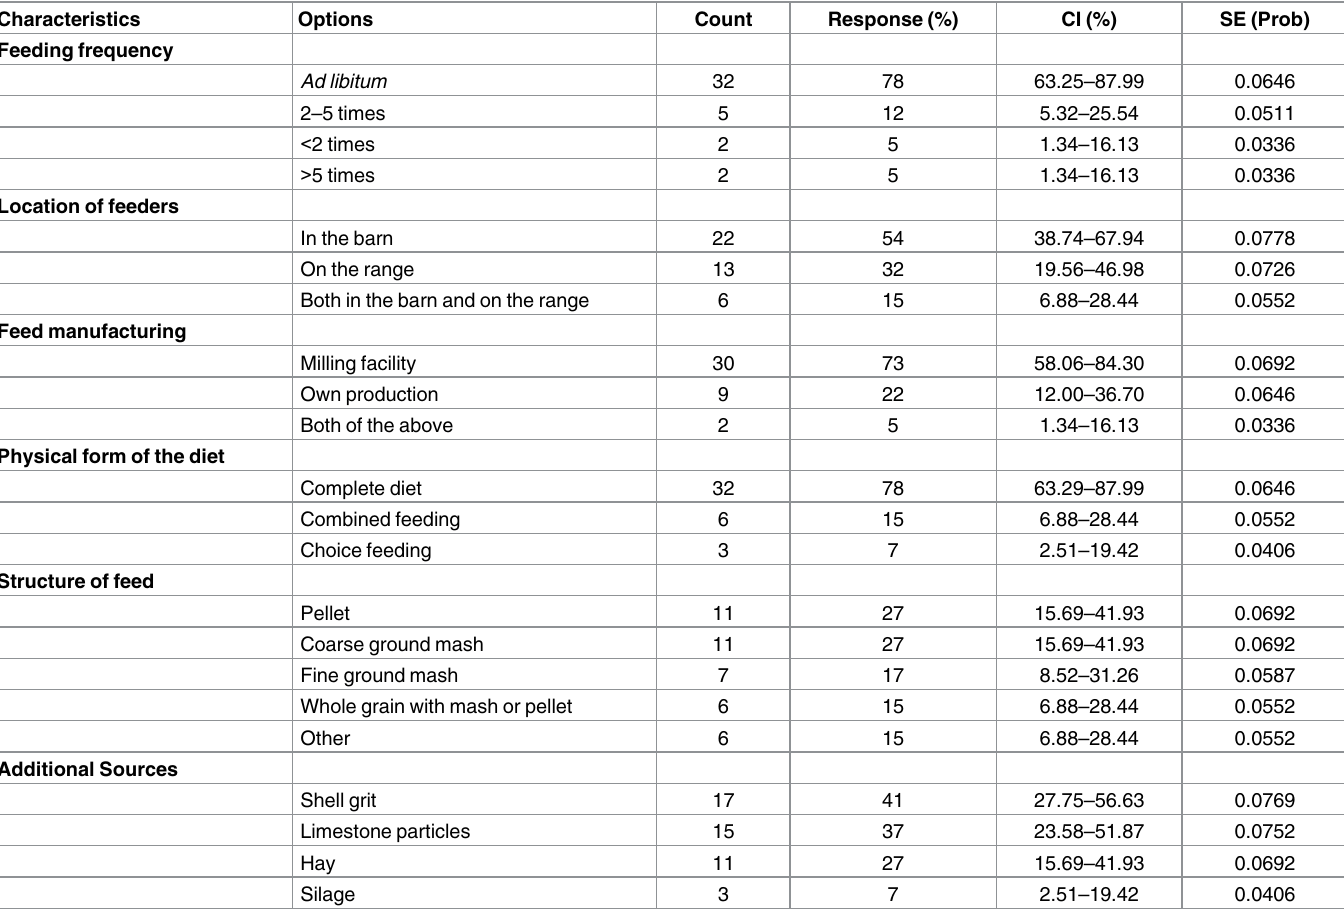
Table 5. Feed characteristics and management as reported by respondent